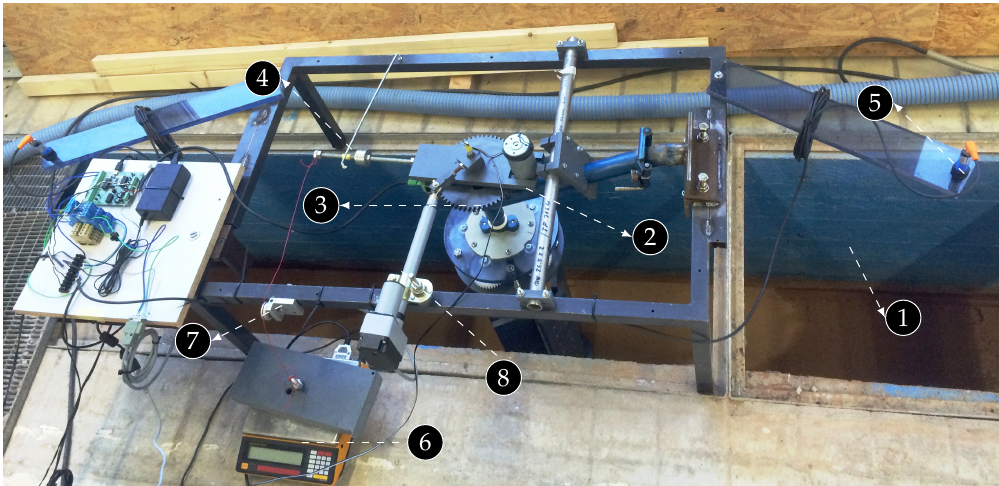
Figure A1. Presentation of the measuring equipment with placeholder blades: (1) duct wall; (2) generator with pinion; (3) turbine with connected main gear; (4) free-floating rod connected to the generator; (5) ultrasonic sensor for the water level; (6) scale with weight; (7) rigid rope which is guided over a pulley; and (8) linear motor for the phase adjustment. It should be noted that the generator only serves as a brake to make the mechanical power output